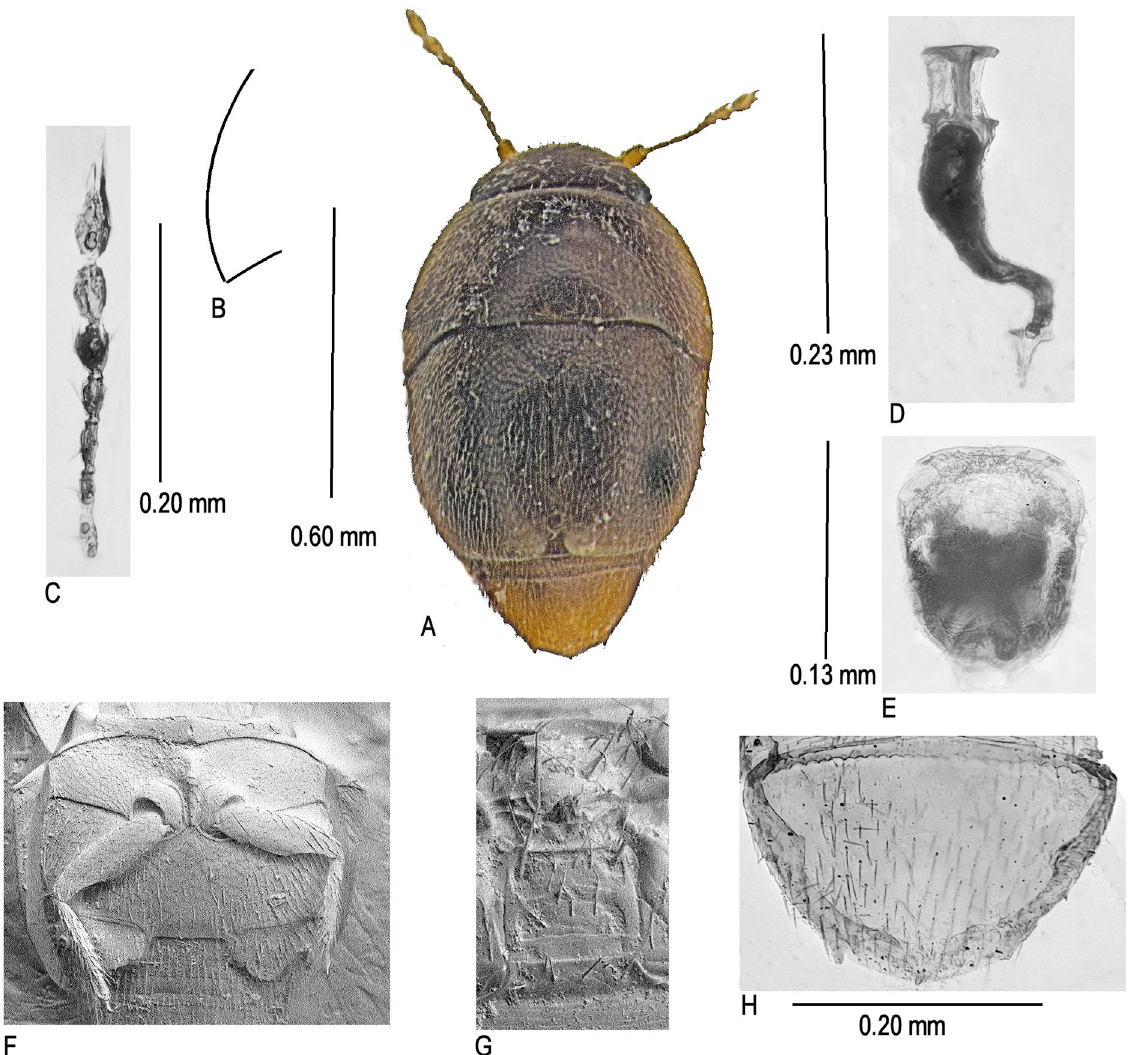
Fig. 19. Acrotrichis globosa sp. nov. A . Habitus. B . Hind angle of pronotum viewed at 45°. C . Antennomeres III–XI. D . Spermatheca. E . Aedeagus. F . Meso- and metaventra ×280. G . Mentum and submentum ×800. H .